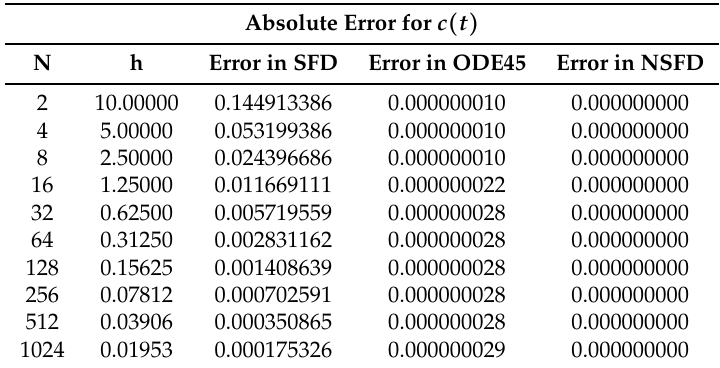
Table 2. The absolute error results for the system of equations given by (13) for c ( t ) with parameter